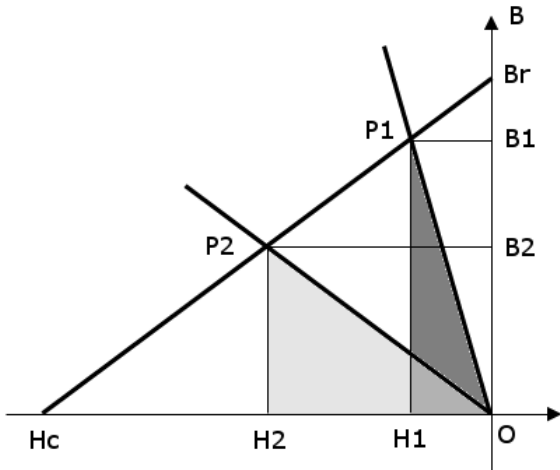
Figure 1. Change of the operating point for a linear circuit.